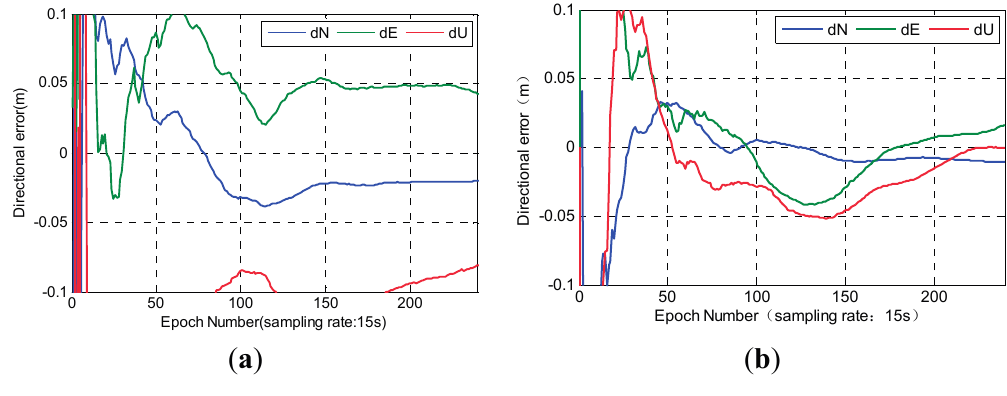
Figure 8. Results of station P091. ( a ) RSDI; ( b )